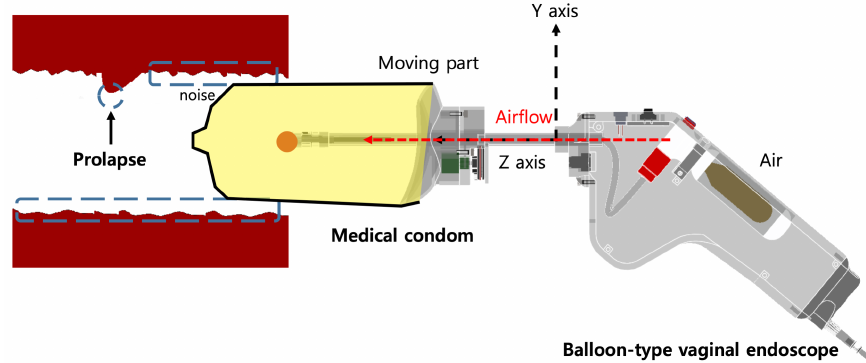
Figure 1. Schematic of concept design in consideration of the requirements for safe insertion in the vaginal endoscope and a depiction of the inflated medical condom to cover the endoscope before